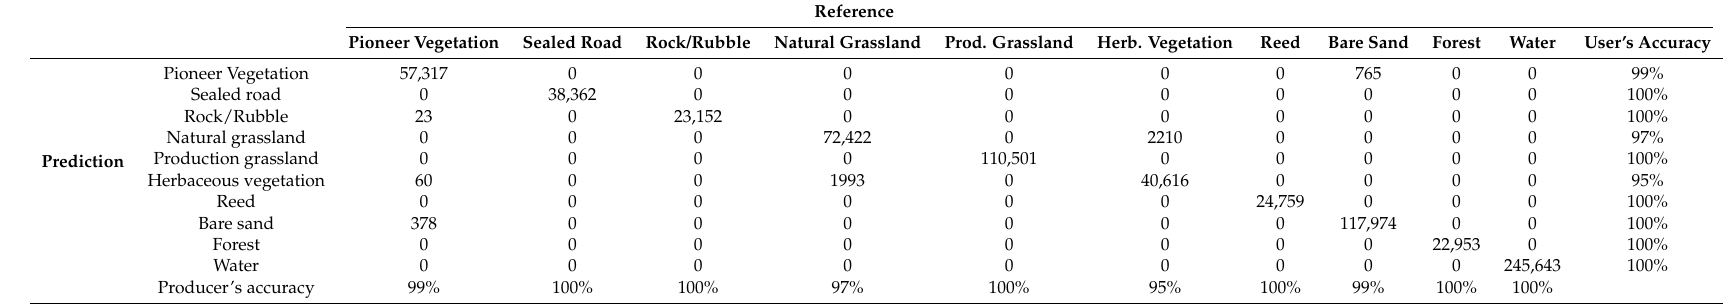
Table 3. Confusion matrix of the RF classification based on all six time steps and with maxnodes of the RF set to default, expressed in numbers of pixels. Reference Pioneer Vegetation Sealed Road Rock/Rubble Natural Grassland Prod. Grassland Herb. Vegetation Reed Bare Sand Forest Water User’s Accuracy Pioneer